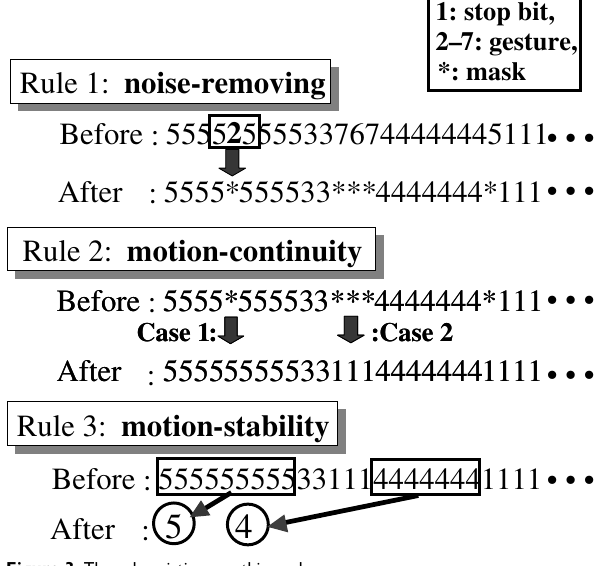
Figure 3 Three heuristic smoothing